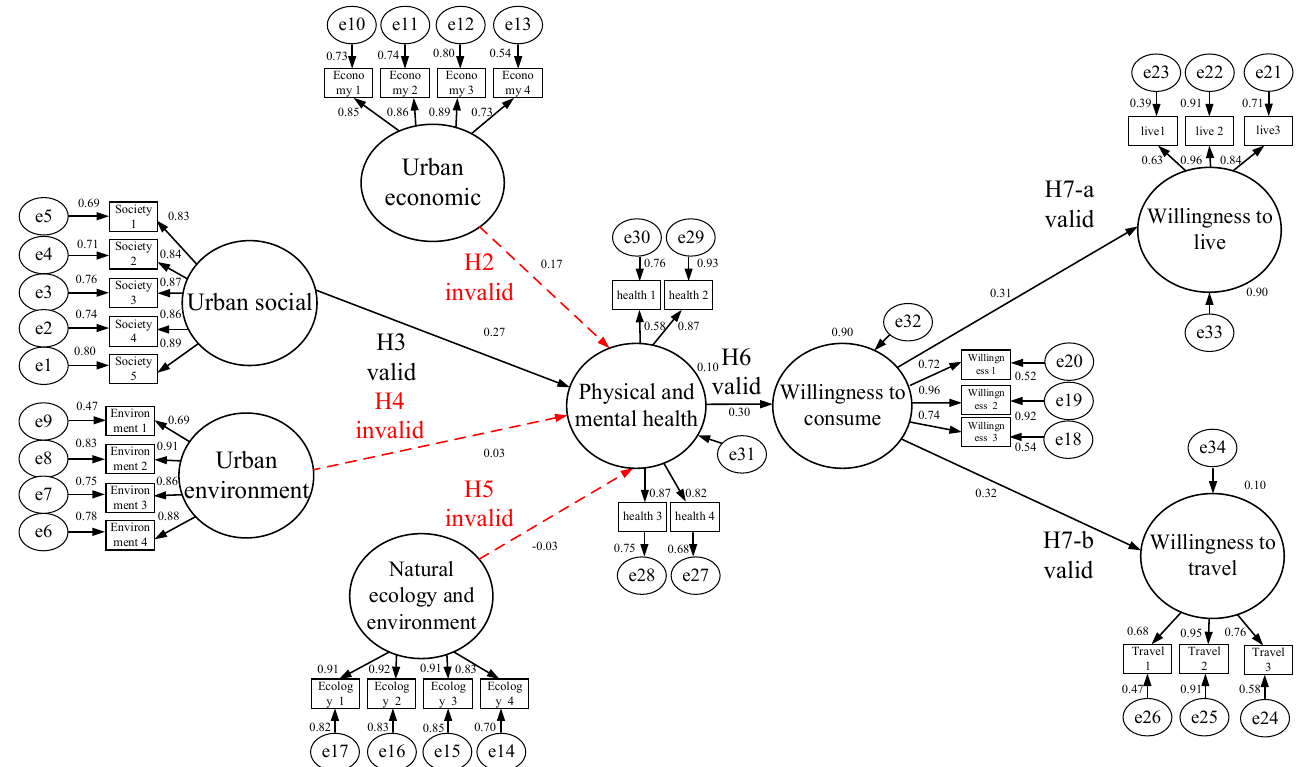
Figure 2. Structural pattern analysis of the impact of urban economy, society, environment, natural ecology, and environmental development on physical and mental health, consumption willingness, living, traveling willingness, and behavior. Table 7. Empirical results of research hypotheses.